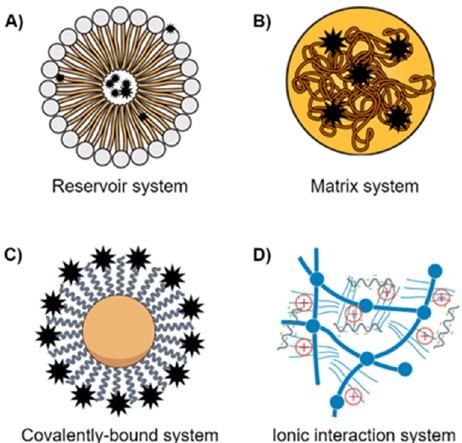
Figure 1. General therapy loading strategies in nanoparticle